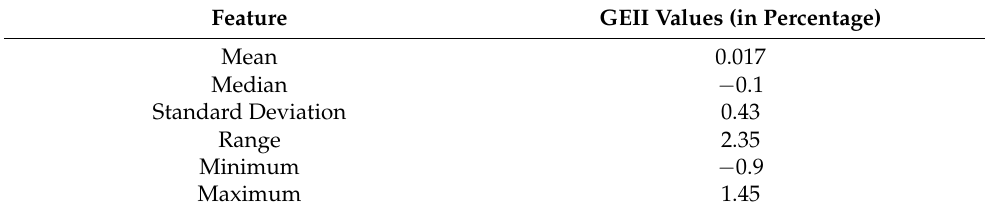
Table 7. Descriptive statistics of GEII for 1992–2019 for 49 U.S. cities.